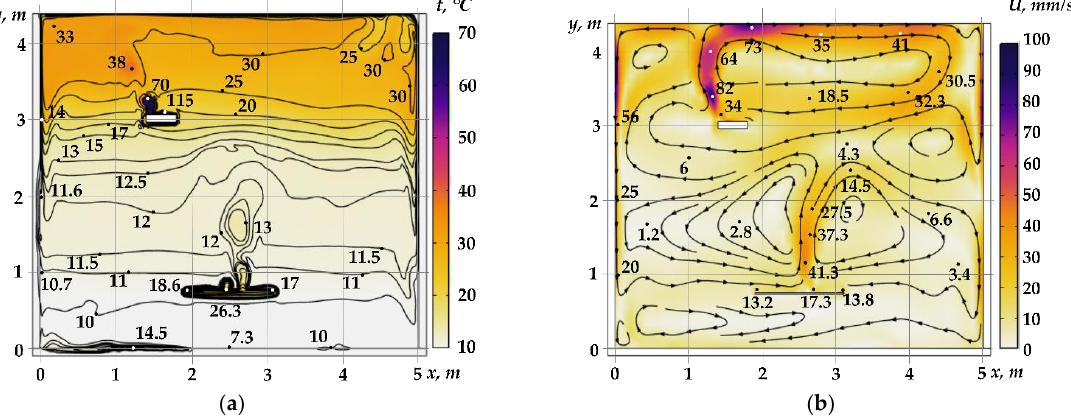
Figure 14. Temperature fields ( a ) and streamlines ( b ) for the area with a panel in the center ( X Tb = 2.5 m, Y Tb = 0.755 m) at τ = 60 min.